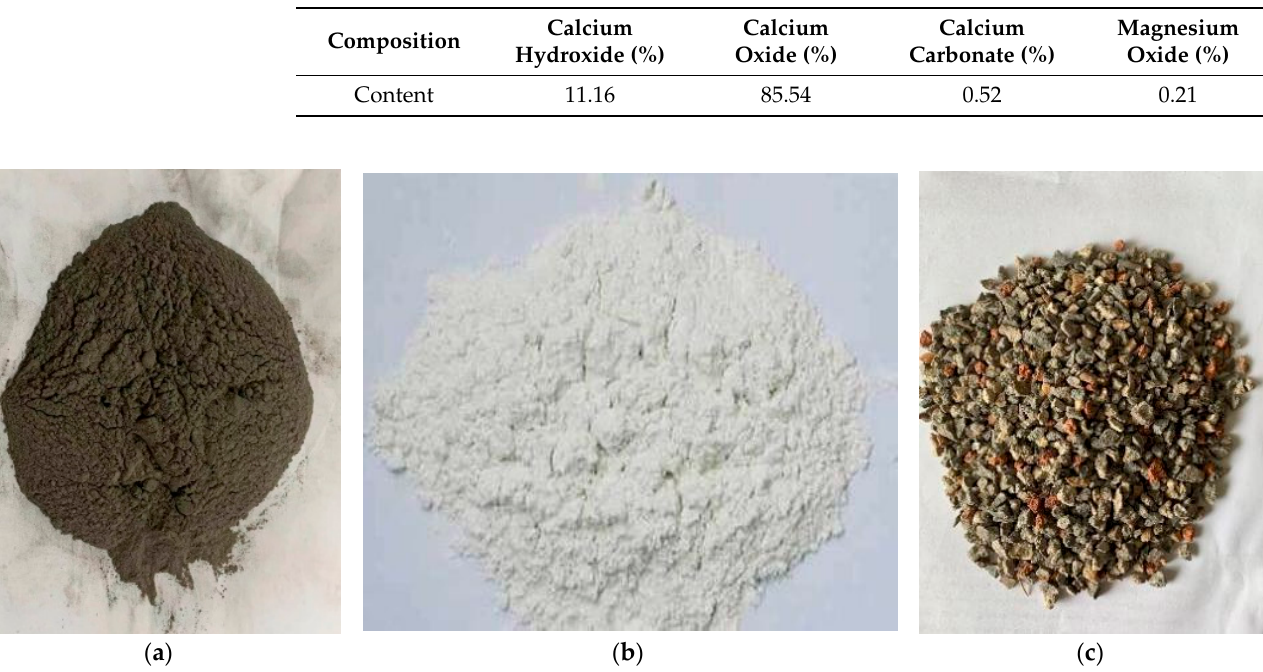
Figure 1. ( a ) fly ash; ( b )lime; ( c ) construction waste aggregate. Table 1. Parameters of fly ash.